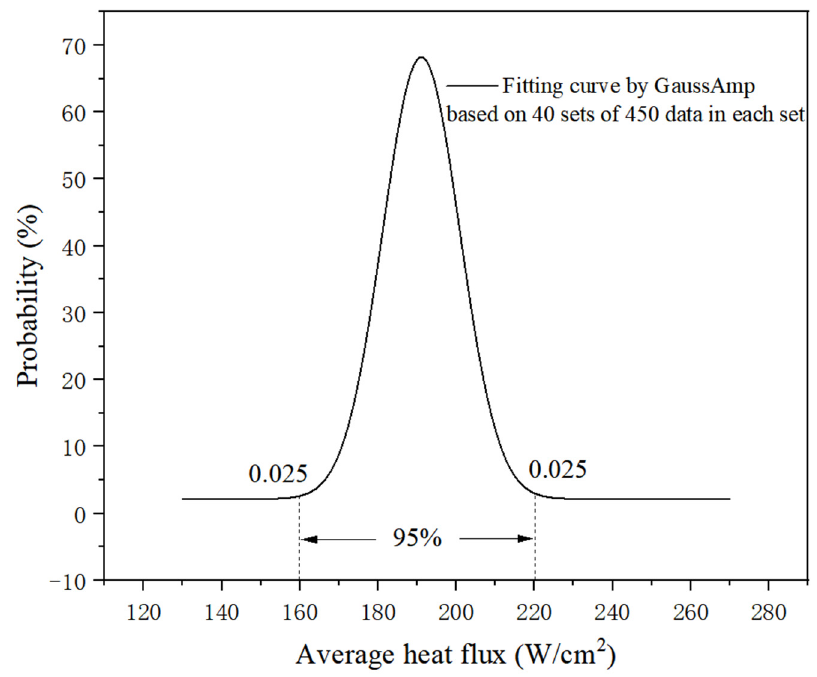
Figure 8. Probability statistics for random heating combinations.